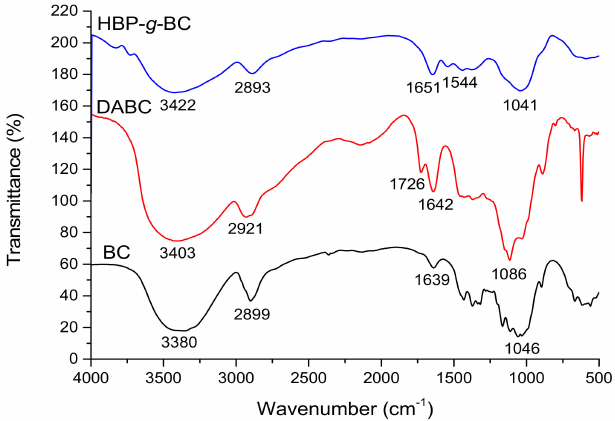
Figure 1. FT-IR spectra of Bagasse Cellulose (BC), Dialdehyde Bagasse Cellulose (DABC), and HBP-NH 2 -Grafted Bagasse Cellulose (HBP- g -BC).